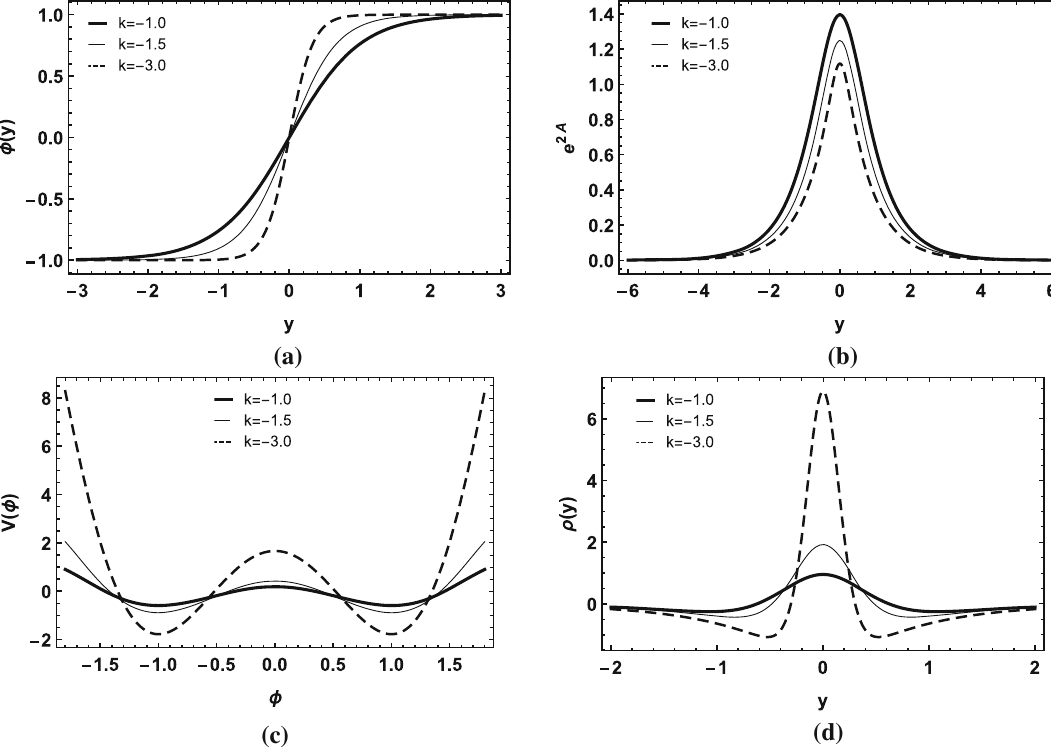
Fig. 2 Plots of the kink solution ( a ), warp factor ( b ), potential ( c ), energy density ( d ), for the polynomial superpotential, where α = β =